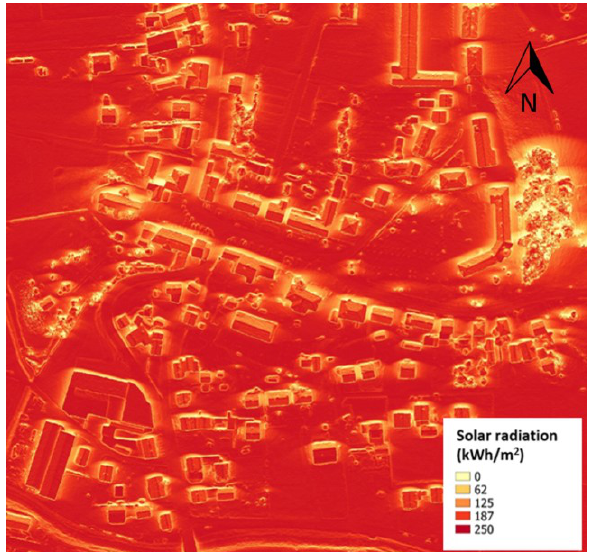
Figure 5. Solar potential of the test area for July